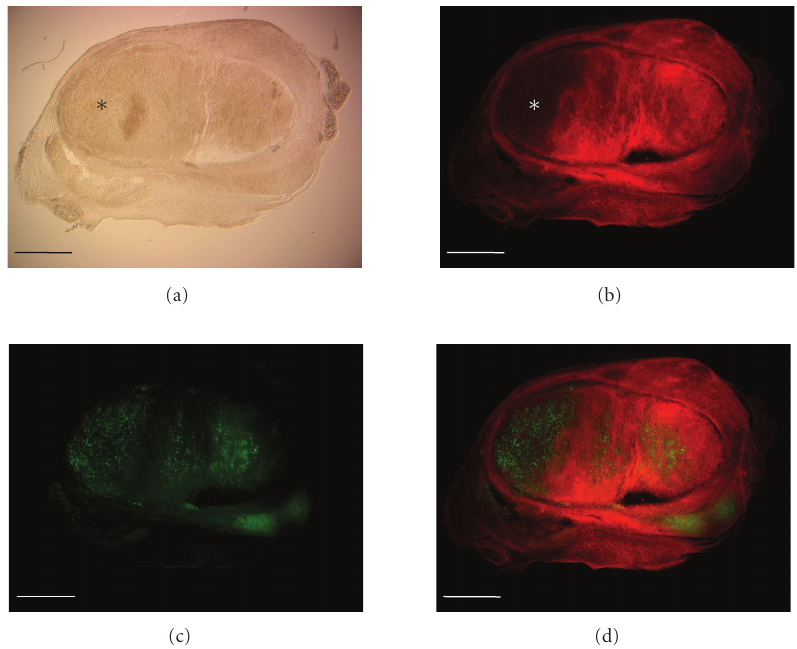
Figure 7: Immunohistochemical staining of a lymph node with PC-3 metastases. At day 57 after PC-3 cells implantation, tumor-bearing mice were injected with 5 × 10 6 pfu of GLV-1h68. At day 11 after virus injection, whole lumbar lymph node cross-sections were analyzed by bright-field imaging (a) or by fluorescence microscopy techniques. (b) Phalloidin-TRITC (red) and (c) anti-VACV antibody (green), and (d) (overlay). Scale bars = 1 mm. ∗ indicates the dead tumor tissue destructed by GLV-1h68.